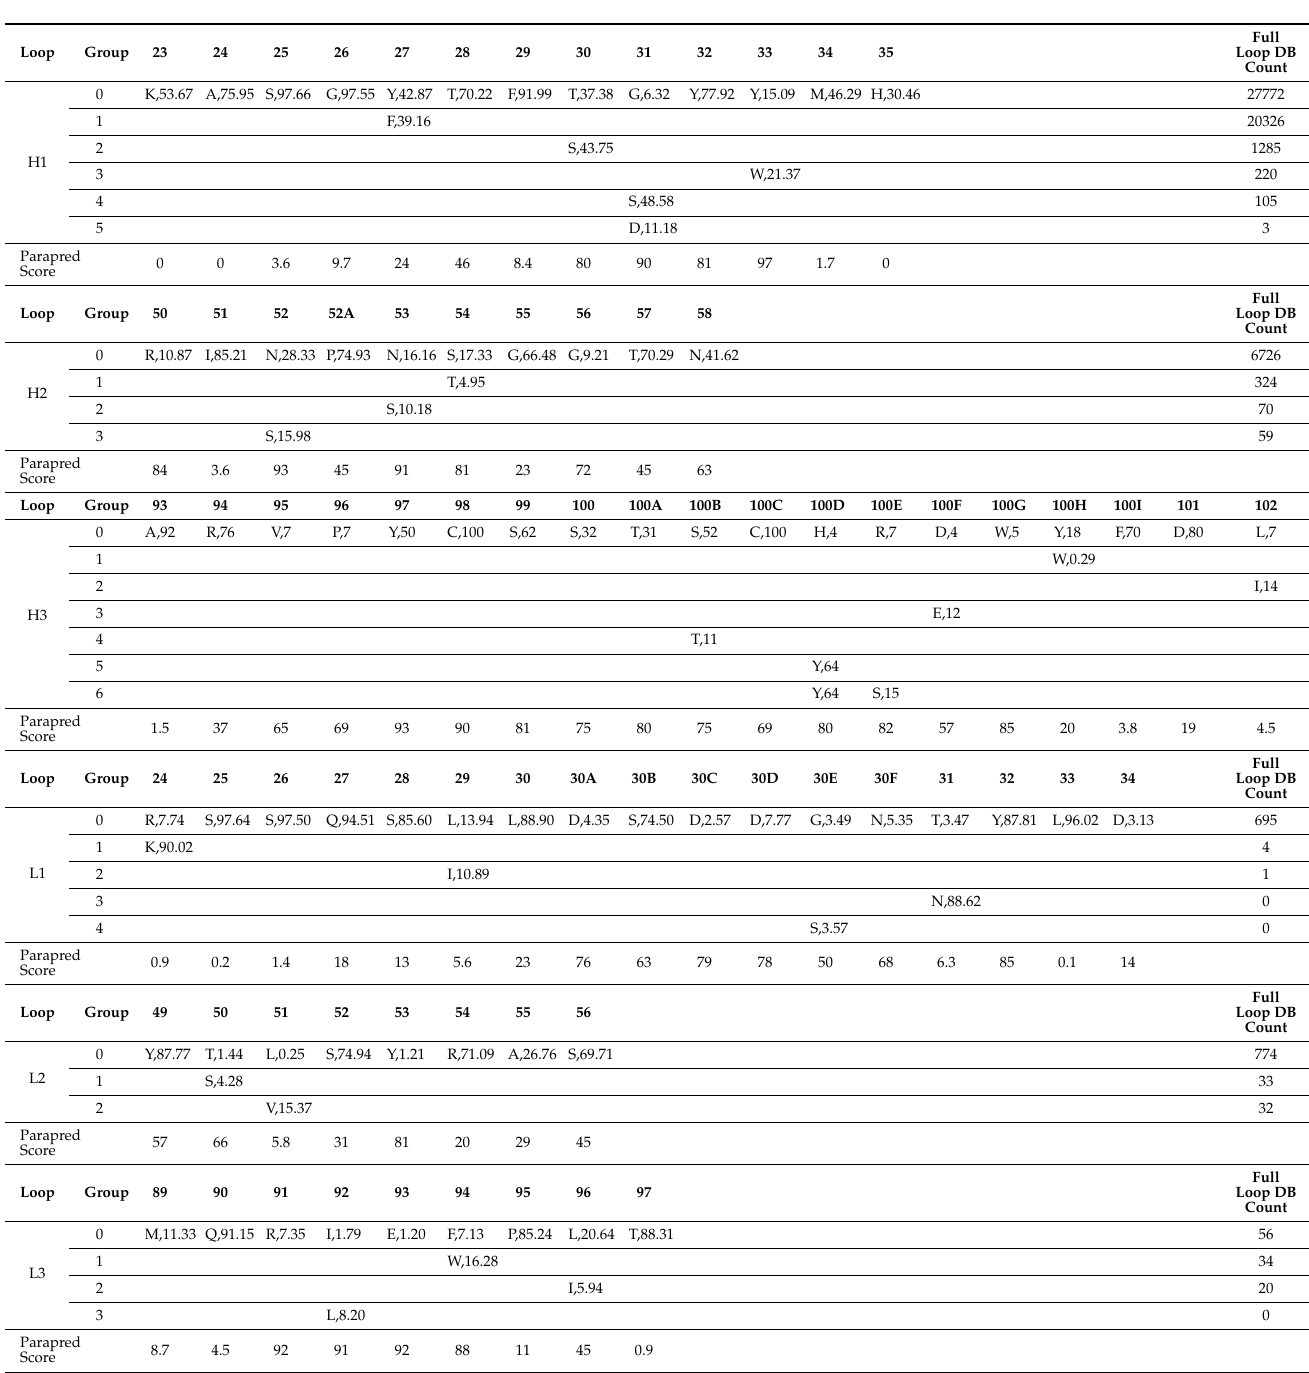
Table 1. CDR library design for antibody affinity maturation. The CDR sites selected for mutations were identified using the scores (‘Parapred score’) assigned by the antibody paratope prediction software, Parapred. Residue substitutions within each CDR were selected based on a combination of factors: (1) the frequencies of amino acids within a canonical class (shown as percent fraction values within the cells); (2) the most commonly occurring CDR homologs within the sequence database (last column of the table); (3) the physiochemical distance between the wild-type residue and the mutant. The CDR homologs are assigned into different groups (2nd column) and assigned distinct labels (also used in Figure 3 and Table